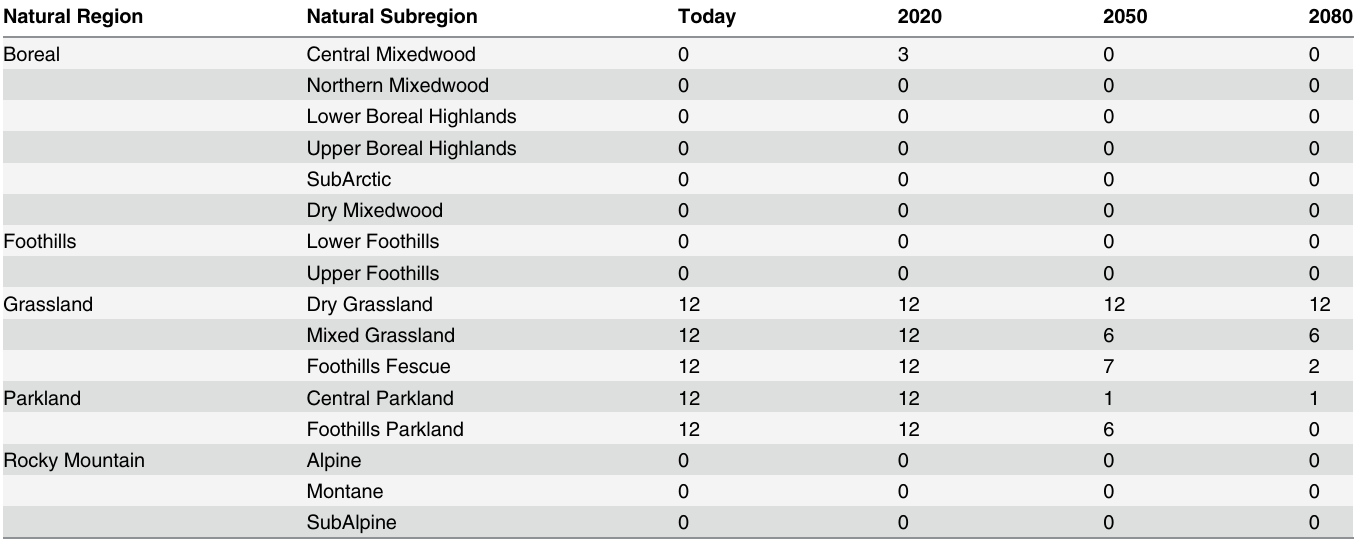
Table 1. Number of occurrences, across all 12 GCM and design scenarios, that ecosystem representation targets were not achieved, by Subregion and time period. Natural